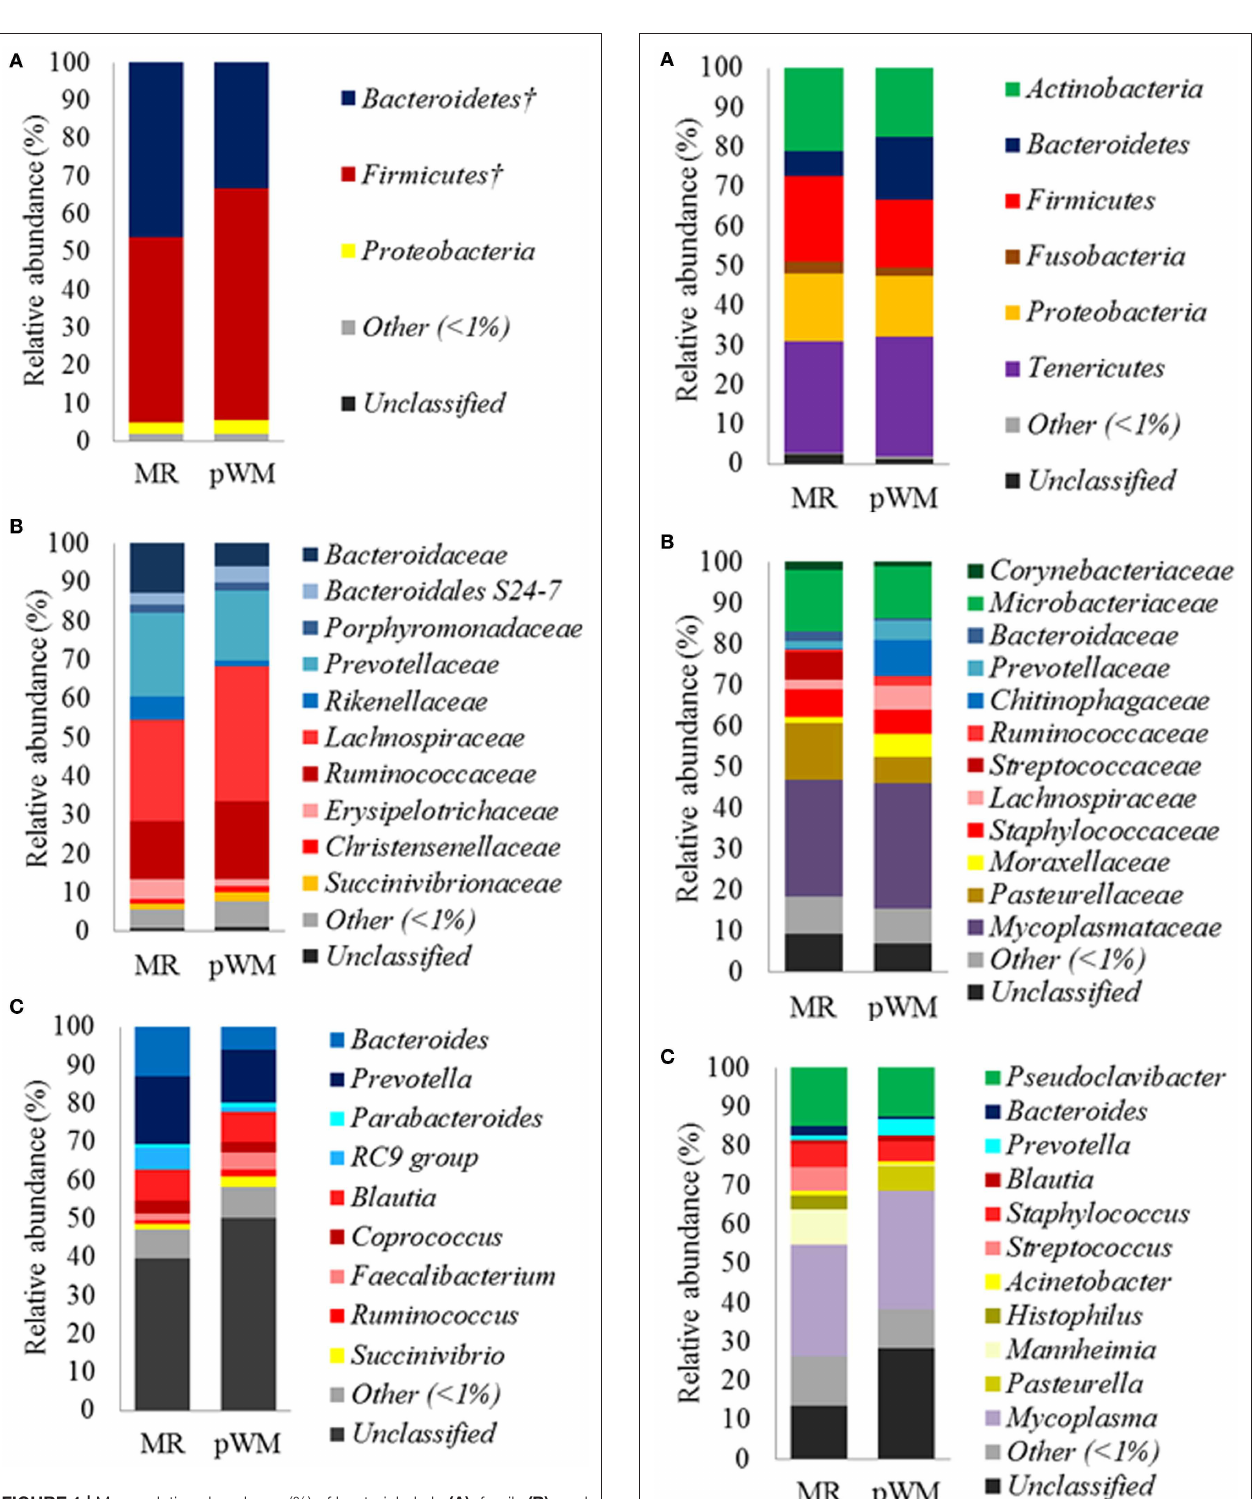
FIGURE 1 | Mean relative abundance (%) of bacterial phyla (A) ; family (B) , and genus (C) , in the fecal microbiota of dairy calves fed either milk replacer (MR) ( n = 8) or pasteurized waste milk (pWM) ( n = 10). † Indicates that the relative abundances of bacterial divisions tended to be different ( P < 0.10) between feeding regimes.